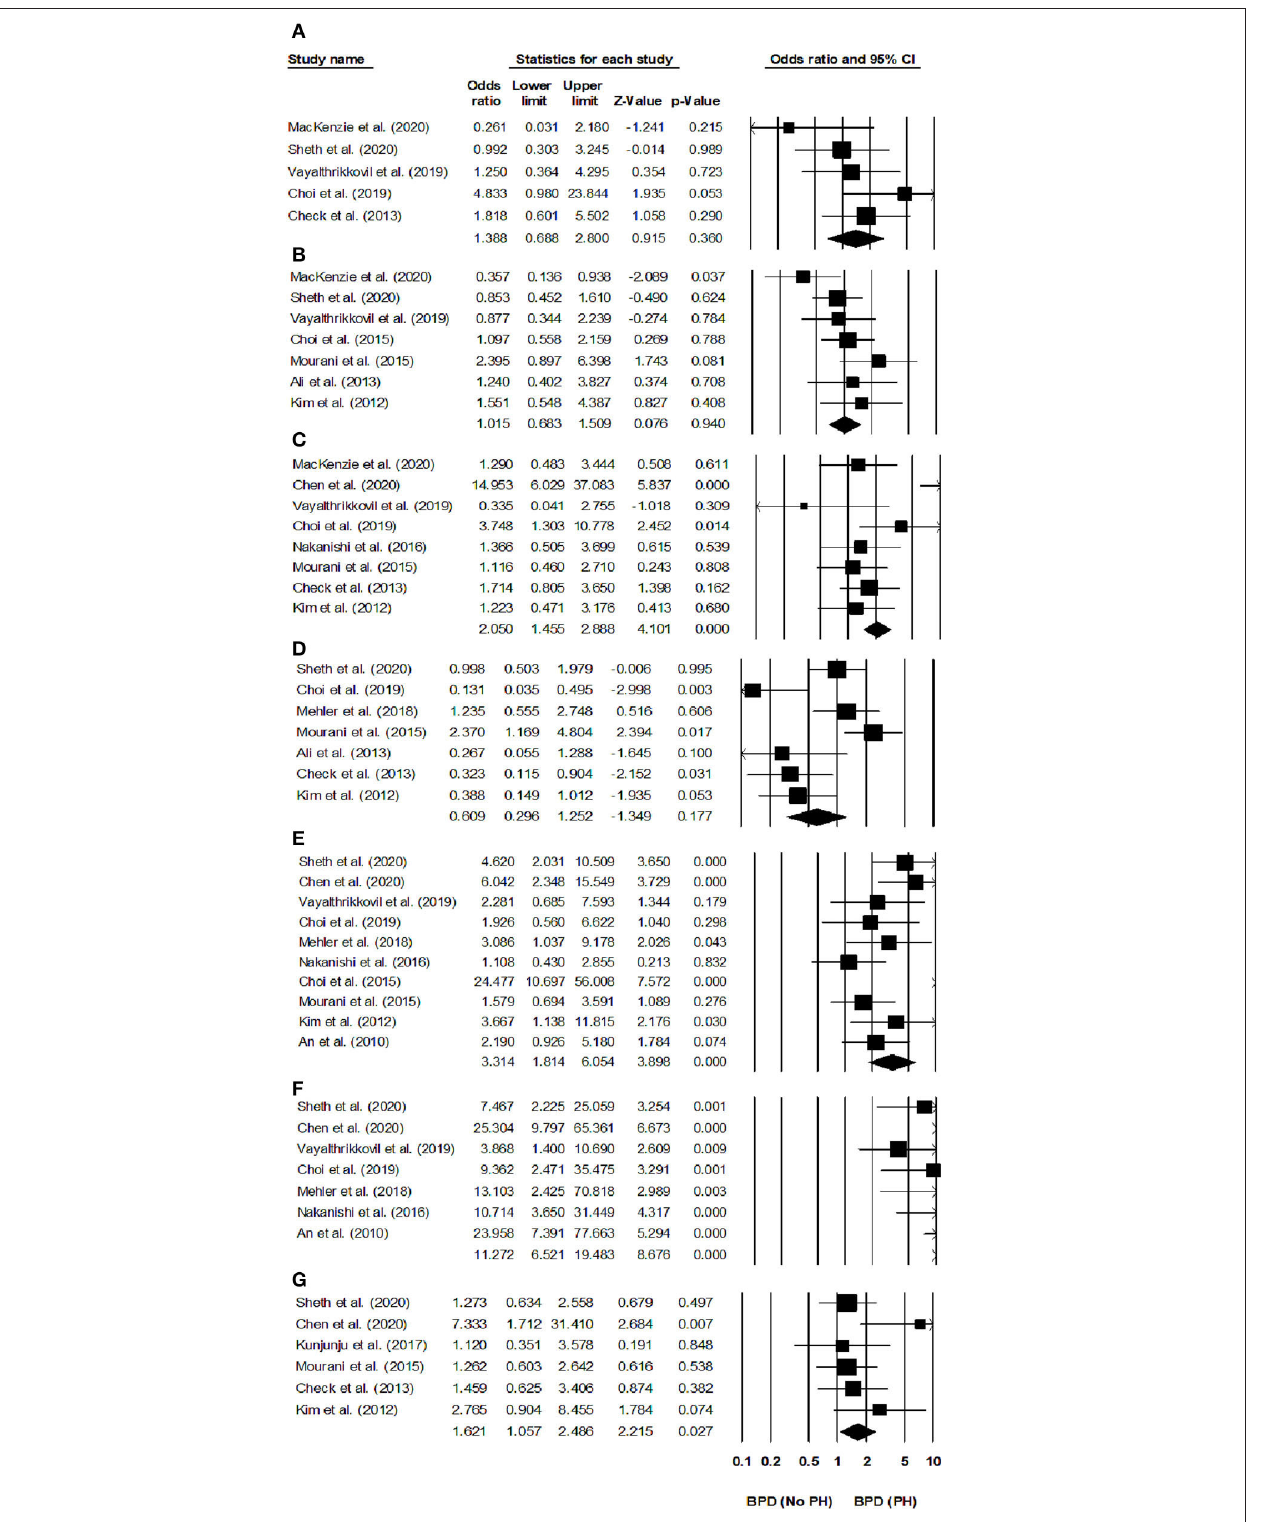
Frontiers in Pediatrics |